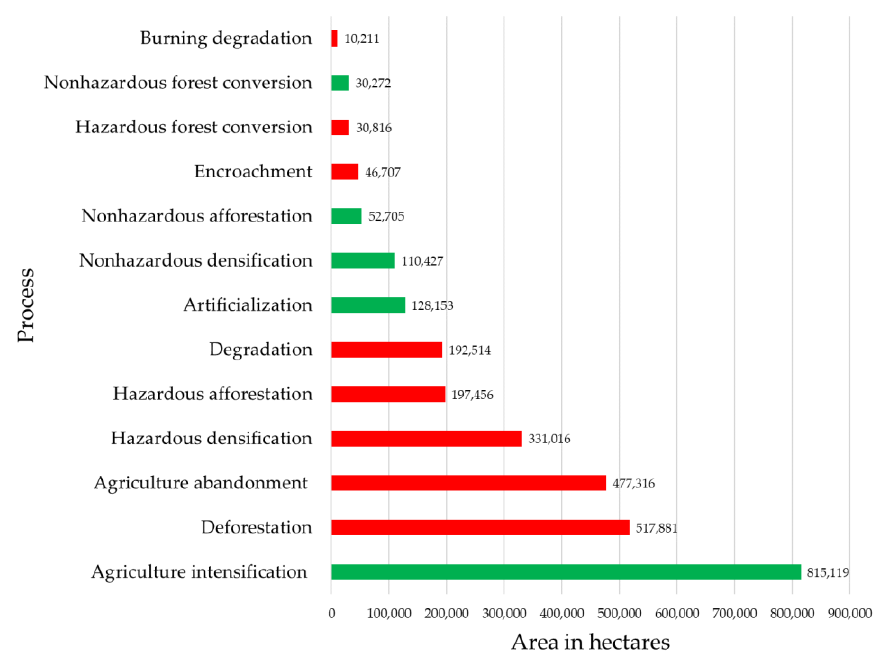
Figure 8. LULC changes accumulated (in ha) during 1984 – 2017, showing LULC hazardous processes (red) and nonhazardous LULC processes (green).